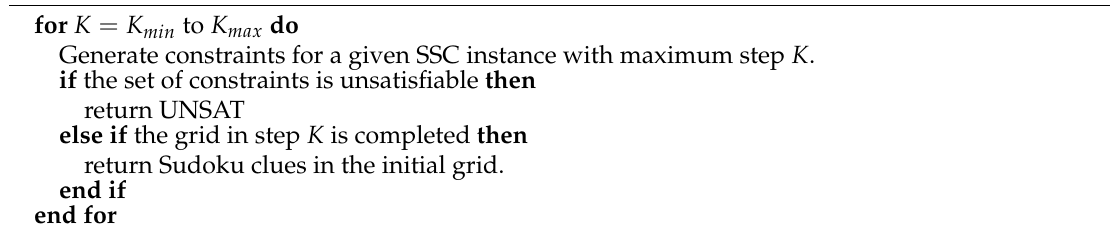
Algorithm 1 Incremental approach for the strategy-solvable Sudoku clues